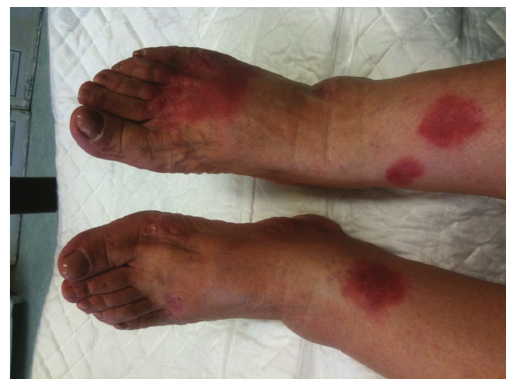
Figure 2: Erythematous and vesicular plaques on the shins and